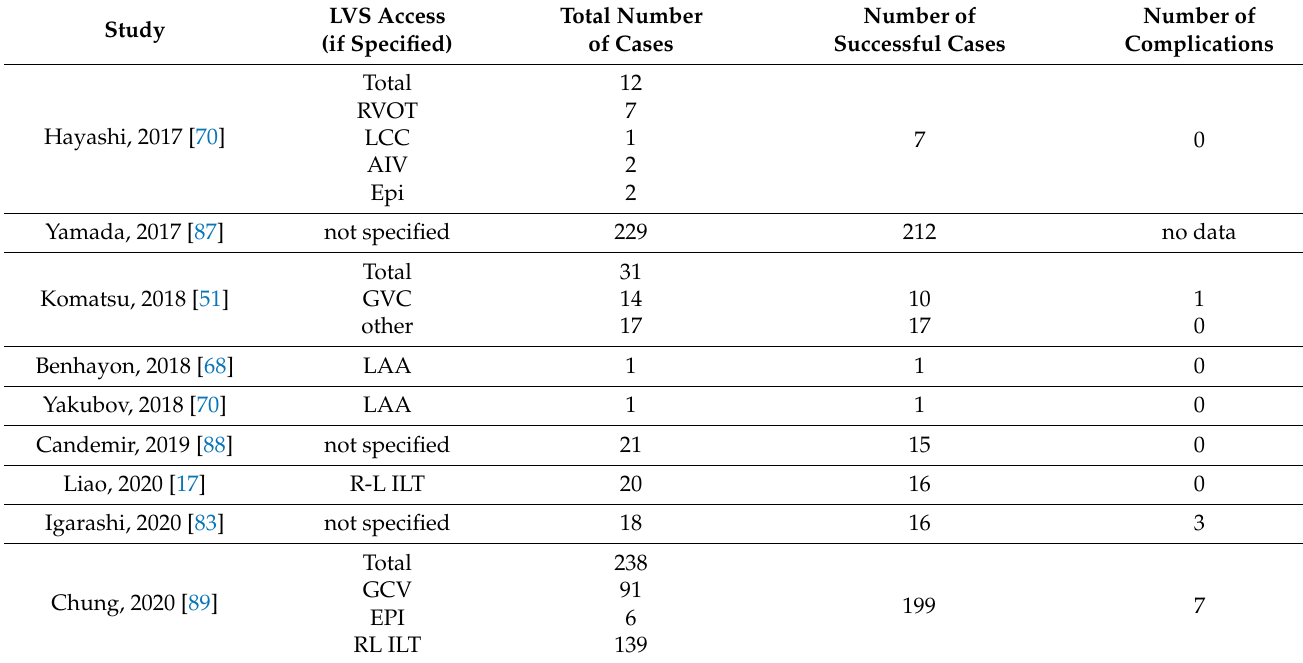
RL ILT = right–left interleaflet region, GCV = great cardiac vein, Epi = epicardial approach, RVOT = right ventricular outflow track, AMC = aortic–mitral continuity, LCC = left coronary cusp, NCC = noncoronary cusp, RCC = right coronary cusp, AIV = anterior interventricular vein, MA = mitral